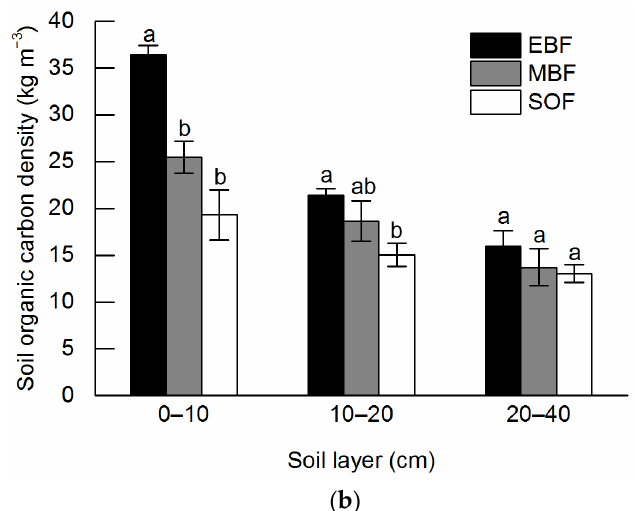
Figure 2. Soil carbon sequestration in three forest types at different depths. ( a ) Soil organic carbon content; ( b ) Soil organic carbon density. Different lowercase letters (a, b) above each bar indicate significant differences among different forest types ( p < 0.05), the same letters indicate no significant differences between each other, and two repeated letters (ab) indicate that the forest type is not significantly different from the other two types. Vertical bars show ± S.E.